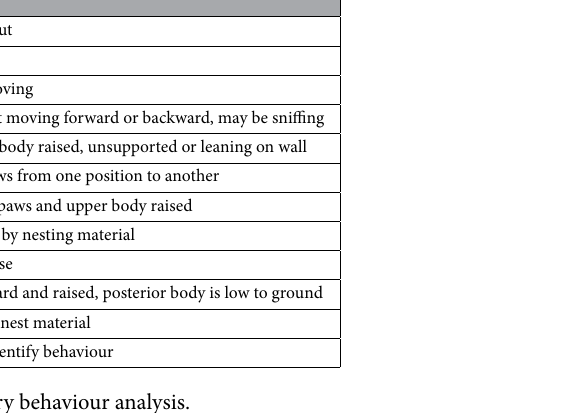
Table 1. Ethogram used for anticipatory behaviour